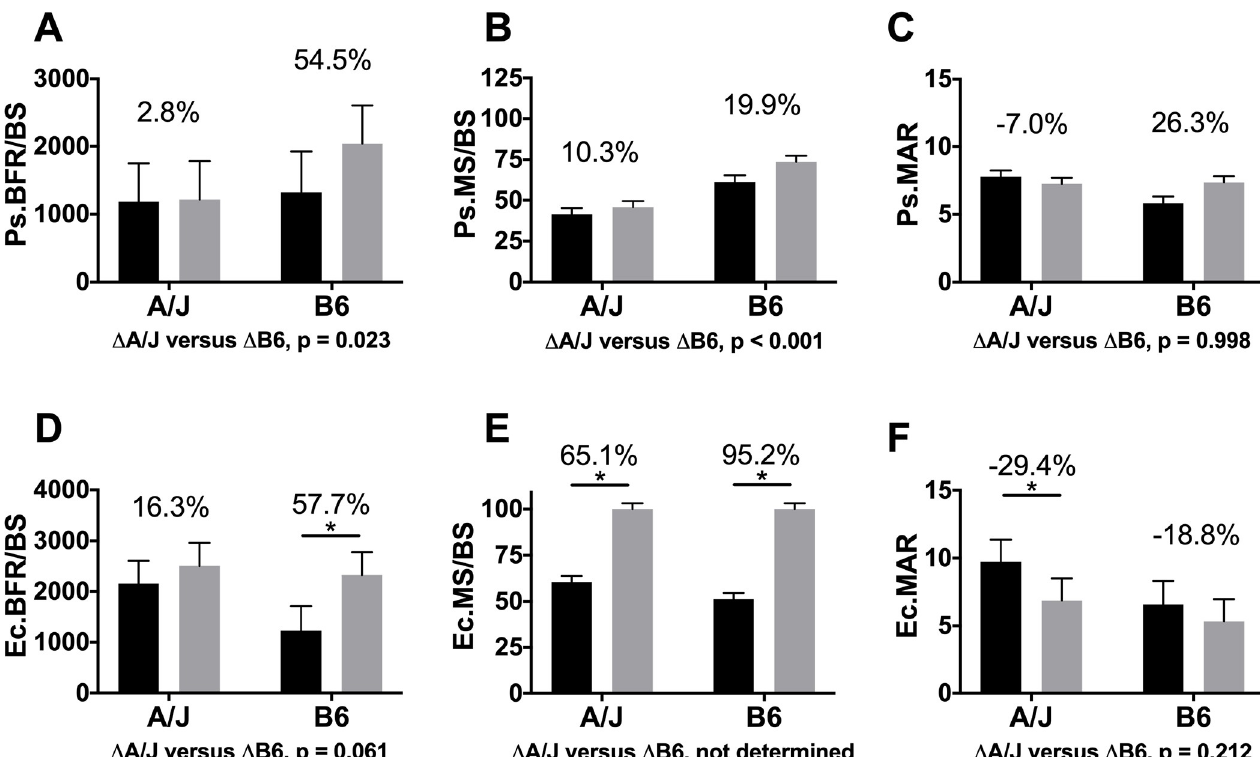
Fig 7. Dynamic histomorphometry analysis. Data revealed a trend towards higher periosteal bone formation rate per unit of bone surface (BFR/BS) in B6 femurs, but not A/J (A), as well as a significantly greater Ec.BFR/BS in B6 femurs, and a trend towards higher Ec.BFR/BS in A/J (D). These changes resulted from greater MS/BS with Scl-Ab treatment on periosteal (Ps.) (B) and endocortical (Ec.) (E) surfaces in A/J and B6 mid-femoral cortex, along with changes in mineral apposition rate (MAR) (C & F). Main effects by strain and treatment as well as the interaction of strain by treatment were tested using an ANOVA. Percent changes were calculated from least square mean differences of Tukey pairwise comparisons (p < 0.05). Black bars = Vehicle and gray bars = Scl-Ab